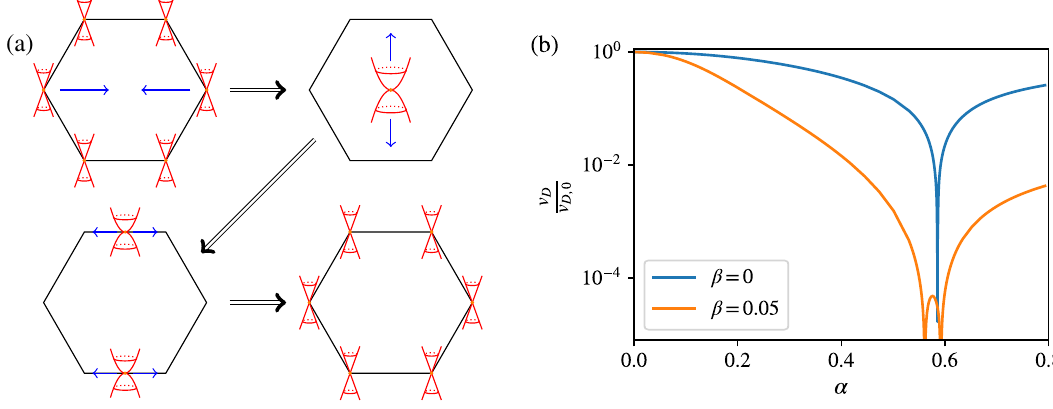
FIG. 10. (a) The trajectory of the Dirac points in a C 3 -broken CTBG near the magic angle when α is varied. For a small symmetry- breaking parameter β the Dirac cones remain close to the K , K 0 points away from the magic angle. Near the magic angle, the displacement δ k diverges and the Dirac cones travel around the BZ, meeting twice to form QBT points at the Γ and M points. (b) The D normalized Dirac velocity at the Dirac cones for C 3 -symmetric ( β ¼ 0 ) and weakly C 3 -broken ( β ¼ 0 . 05 ) CTBG Hamiltonian Eq. (E1). In the C 3 -broken case, the Dirac velocity vanishes twice, at the two QBT points.